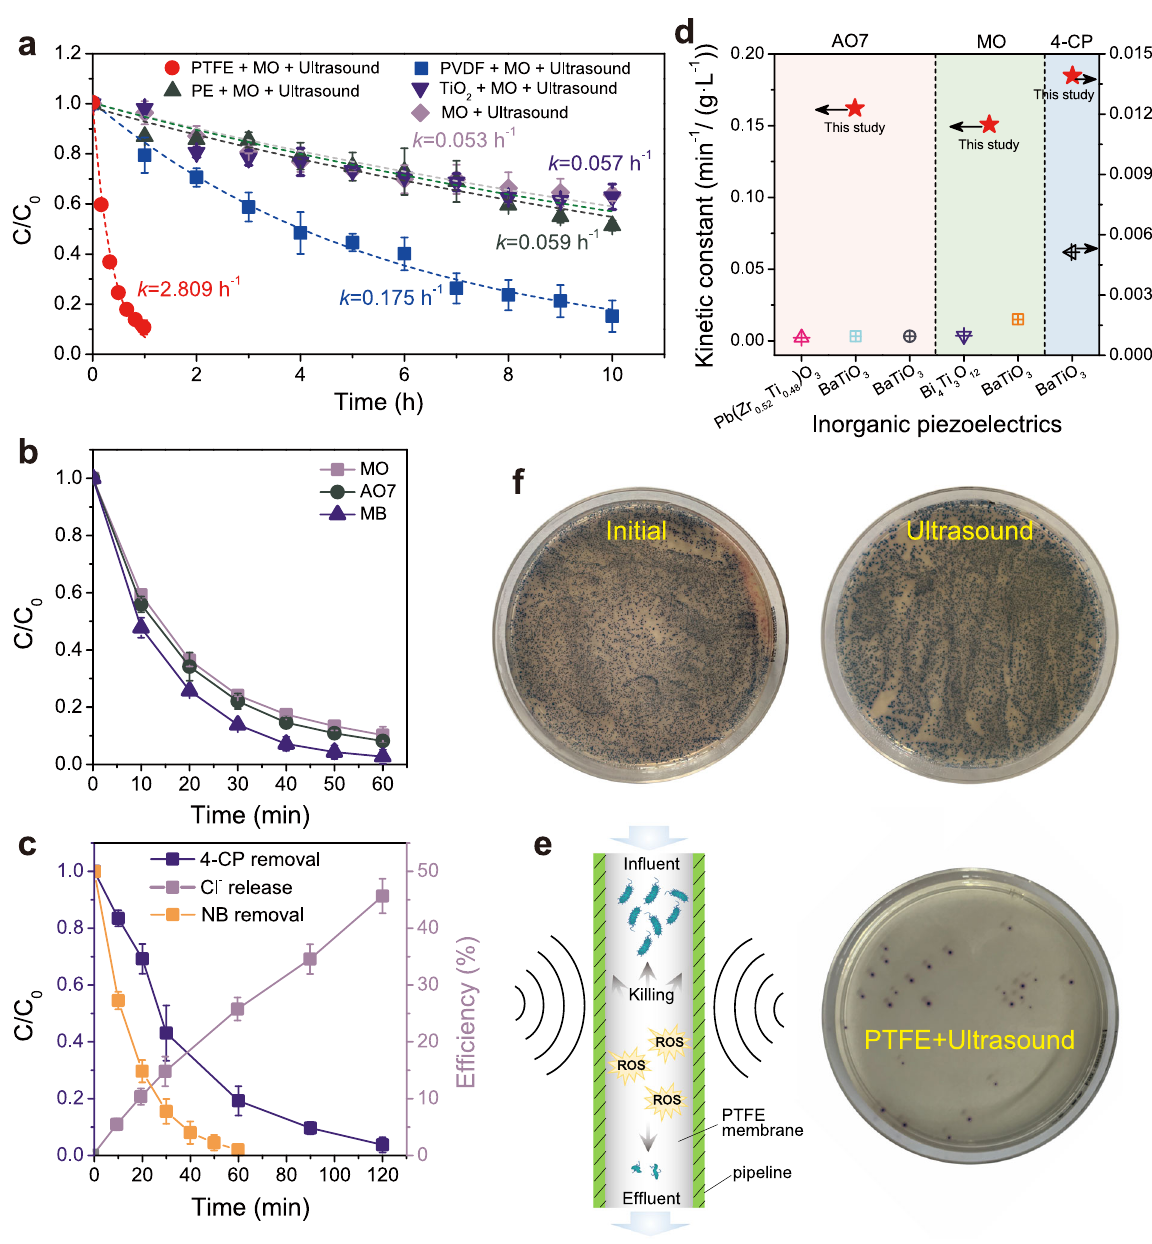
Fig. 4 Potential application of PTFE piezocatalyst. a Comparison of catalytic activities between PTFE and PVDF, Polyethylene (PE), TiO 2 . Piezocatalytic transformation of b dyes and c NB, 4-CP. d PTFE piezocatalytic activities compared with those of inorganic piezoelectric materials, detail information see Supplementary Table 1. e Schematic illustration of PTFE membrane for drinking water disinfection under ultrasound irradiation. f Photography of E. coli colonies on agar culture plates before and after